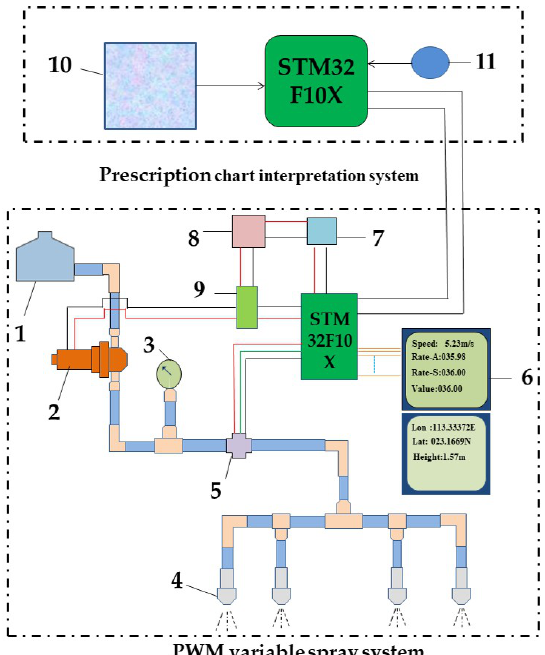
Figure 1. Schematic diagram of the structure of a prescription graphical interpretation of a variable spray system. PWM: pulse width modulation. Note: 1. Medicine box; 2. micro-diaphragm pump; 3. digital pressure gague; 4. pressure nozzle; 5. hall flow sensor; 6. liquid crystal display (LCD); 7. buck module; 8. 12 V direct-current (DC) power; 9. drive amplification module; 10. prescription figure; 11. GPS.